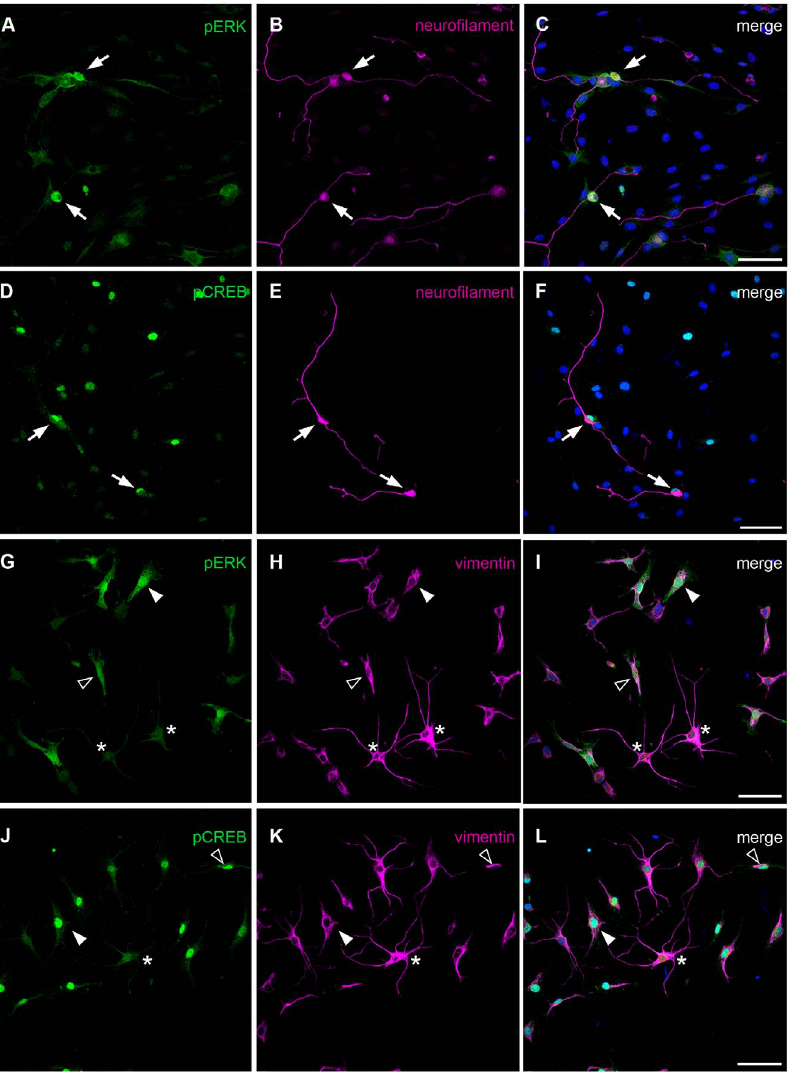
Figure 3. ERK and CREB activation in neurons and distinct vimentin-positive cells by Rolipram/BDNF co-treatment. Projections of collapsed confocal scans showed double-stainings with pERK (A, G) or pCREB (D, J) antibodies and antibodies directed against neuron-specific 200 kDa neurofilament (B, E) or vimentin (H, K) in spiral ganglion cell cultures pre-treated with BDNF (47 h, 30 min) and exposed to Rolipram for 30 min. Nuclei were stained with DAPI. Arrows point to an intense labelling of pERK (C, F) or pCREB (I, L) in the somata of stained SGN. Additionally, pERK (C, F) and pCREB (I, J) immunosignals were present in distinct vimentin-positive cells with a flattened (filled arrowhead) or spindle-shaped (unfilled arrowhead) morphology. Asterisks mark cells with a star-like morphology with a weak reactivity for pERK. Scale bar: 70 m m in C, 75 m m in F, I, L).